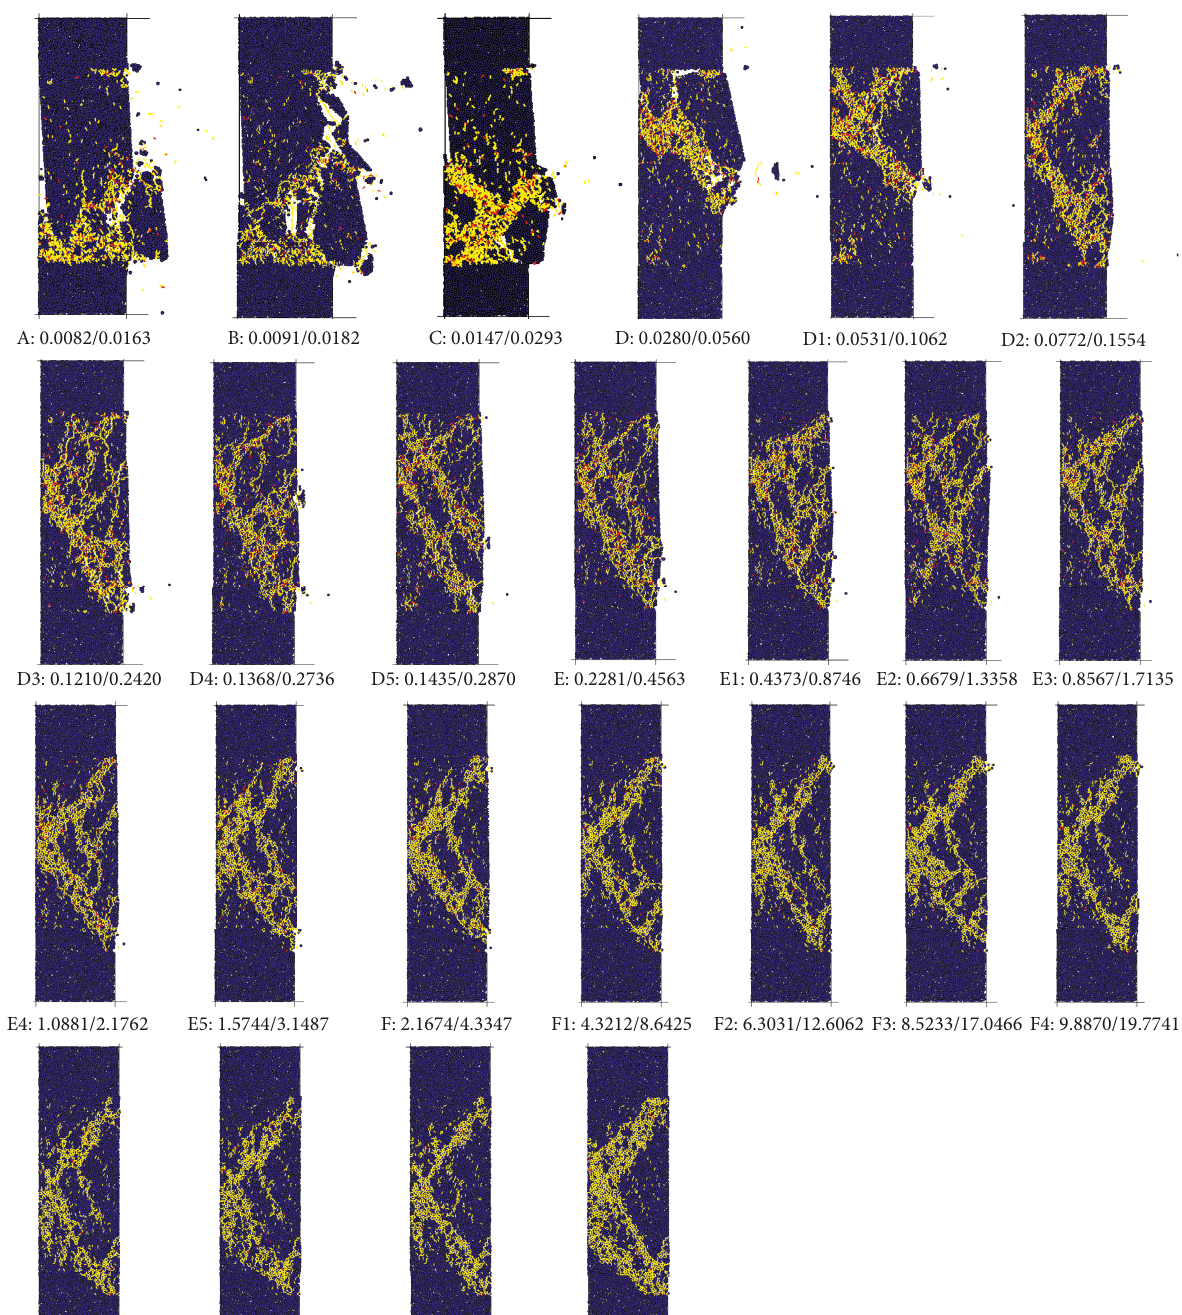
Figure 7: Failure modes and crack distribution after excavation in the PFC tests considering different system stiffness ratios. The numbers under each model are Young’s modulus ratio ( R E ) and stiffness ratio ( R K ),